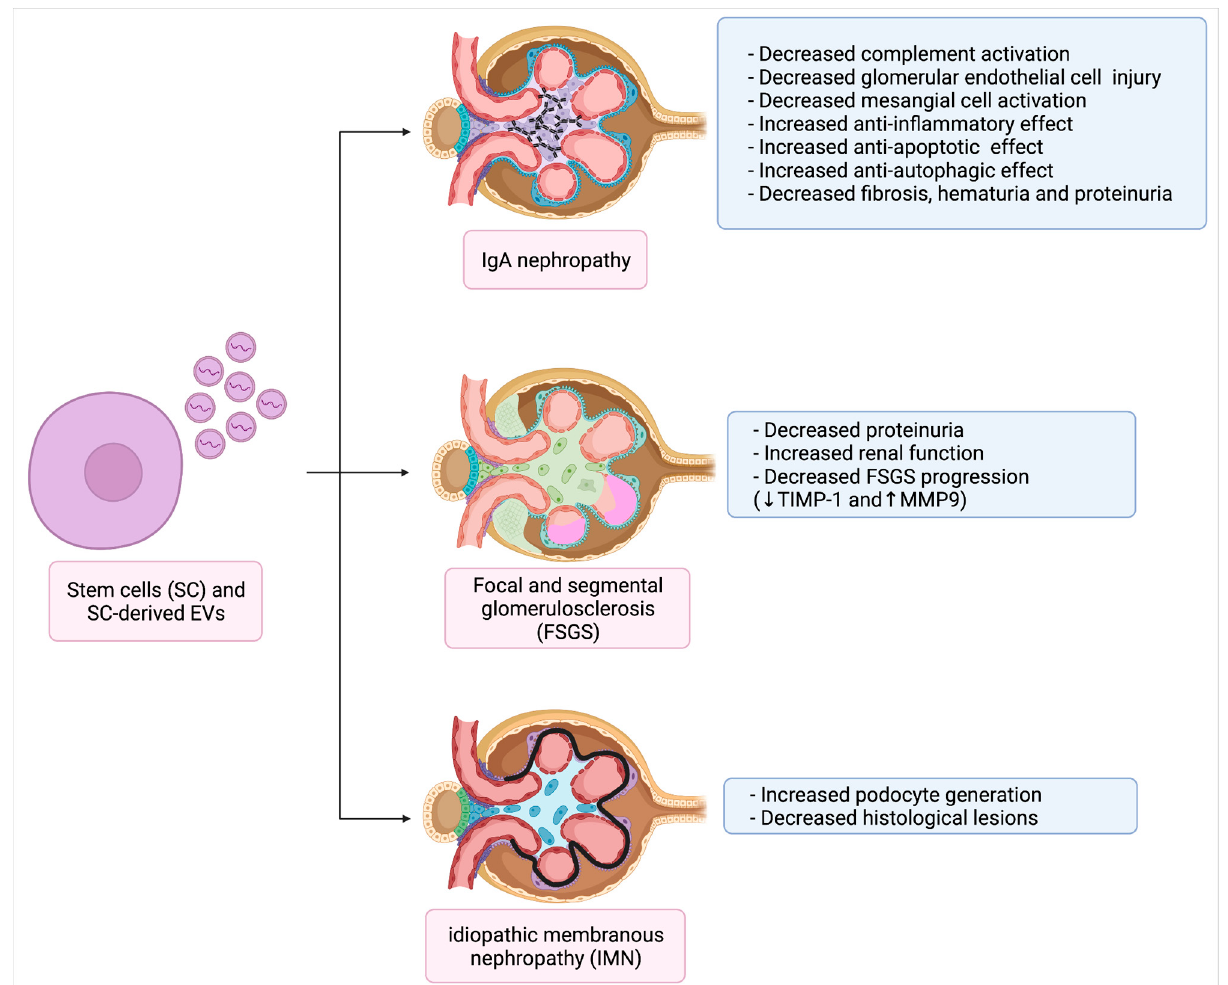
Figure 2. Stem cells and EVs as therapeutic tools for primary GN (Created with BioRender.com).